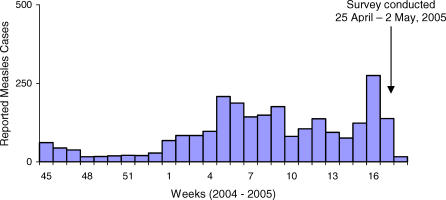
Reported Measles Cases, Adamawa State, Nigeria (2004–2005) (2,505 Patients)